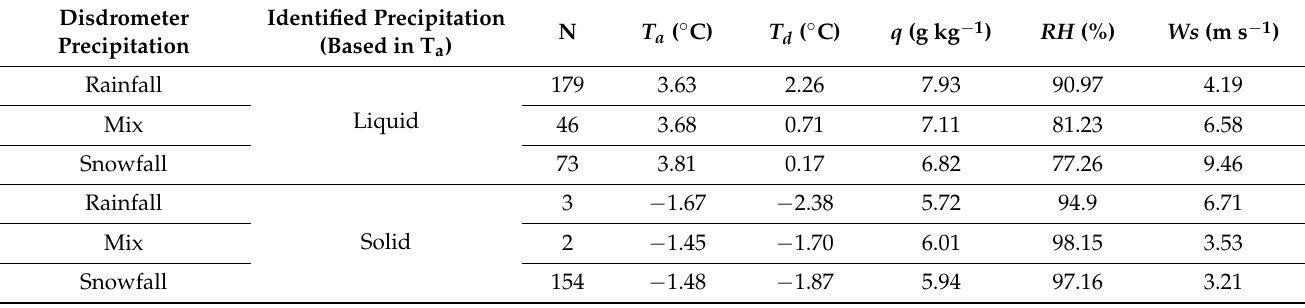
Table A1. Mean meteorological conditions for rainfall, mixed and snowfall reported by disdrometer concerning liquid and solid precipitation